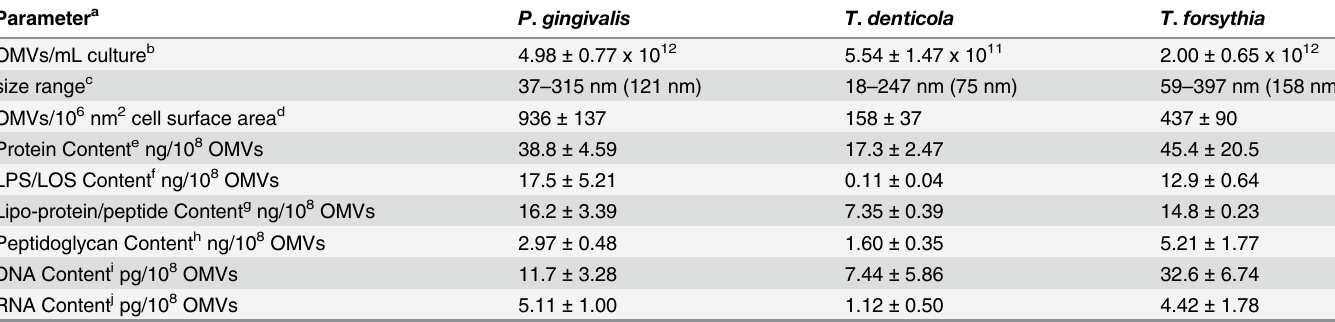
Table 1. Compositional analysis of OMVs from P . gingivalis , T . denticola and T . forsythia . Parameter